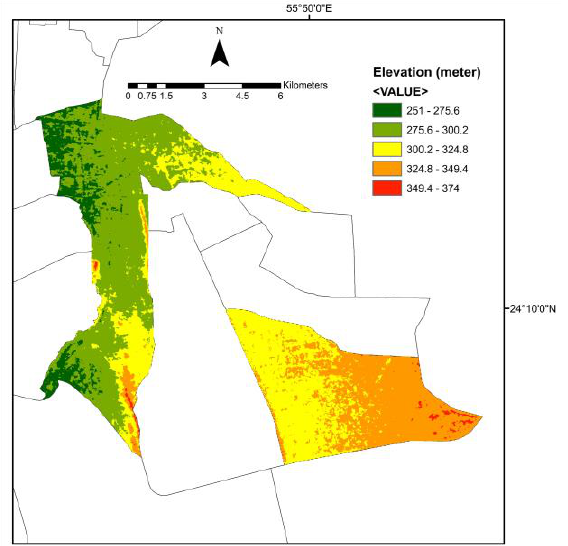
Figure 4. Potential farms and vacant land for food bank